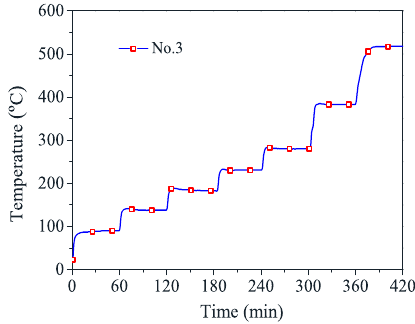
Figure 3. Time–temperature curve for no. 3 point.